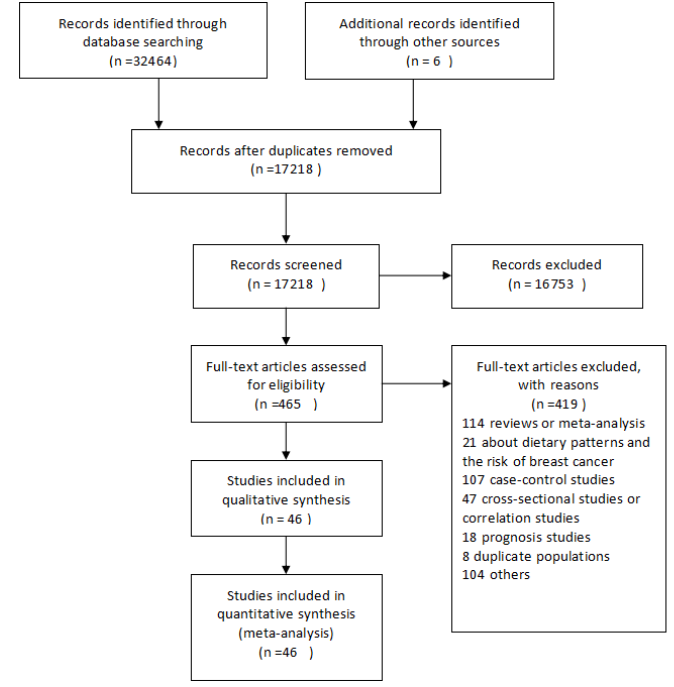
Figure 1. Flow ‐ chart of study selection. Table 2. Associations between specific protein sources and breast cancer incidence. High vs.